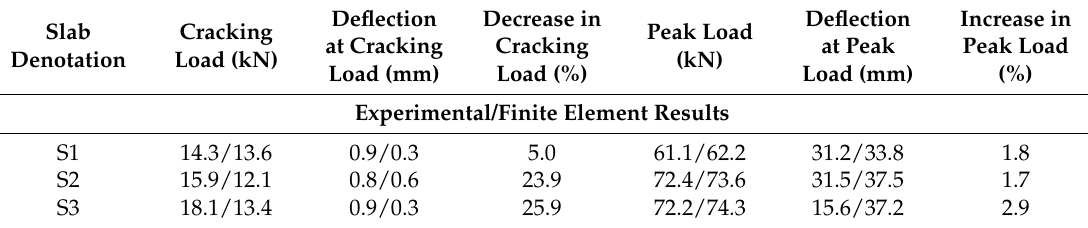
Table 7. Comparison between experimental and finite element results.